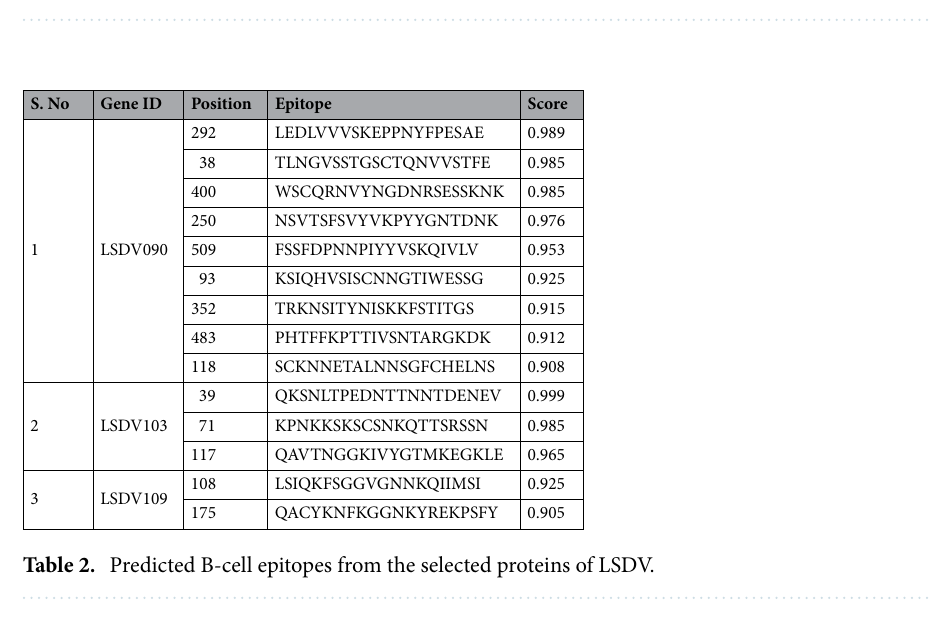
Table 1. List of antigenic proteins LSDV and proteins non-homologous to bovine.